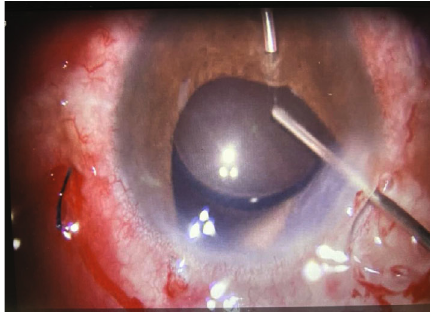
Figure 7: Anterior vitrectomy is performed during the scleral interlamellar fi xation procedure.